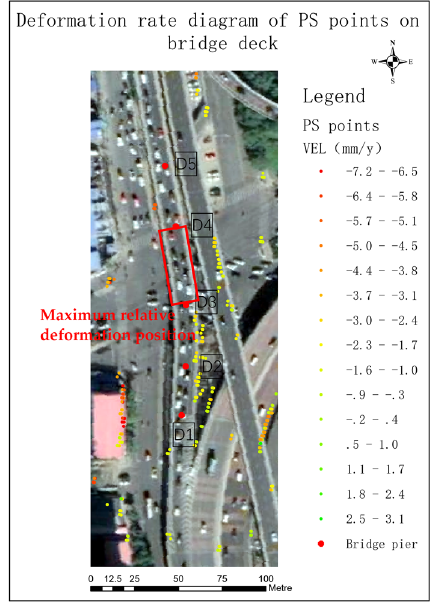
Figure 14. Maximum relative deformation position in Cosmo-SkyMed SAR image.